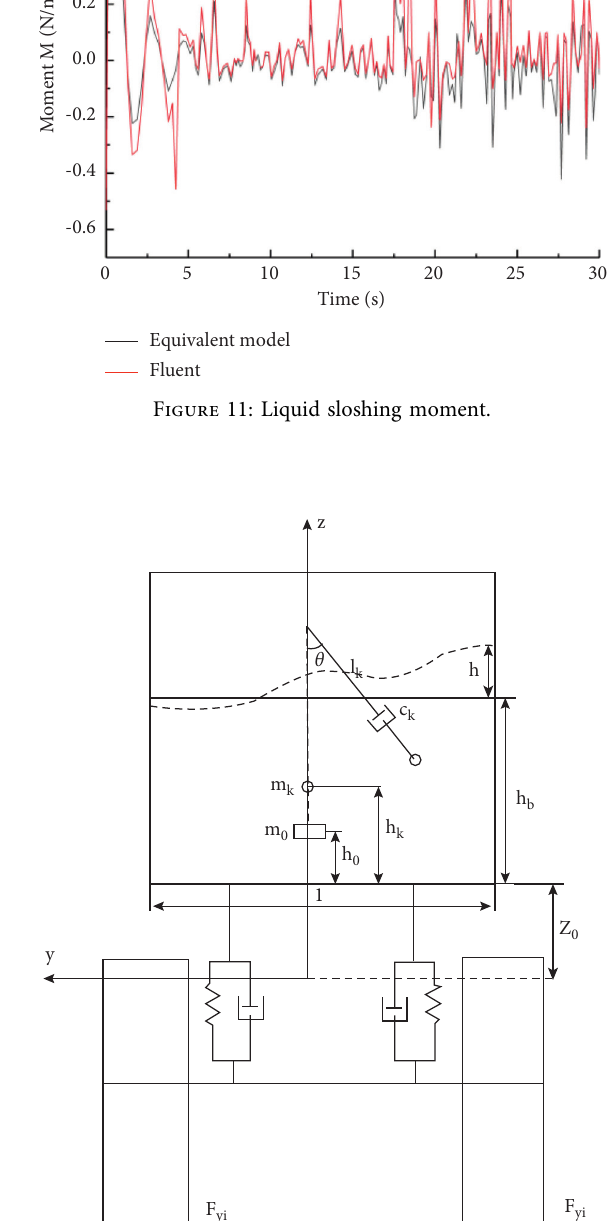
Figure 12: Roll model of the high-clearance